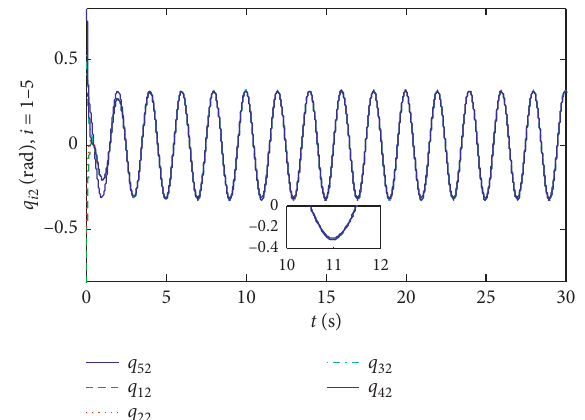
Figure 16: The generalized coordinates q